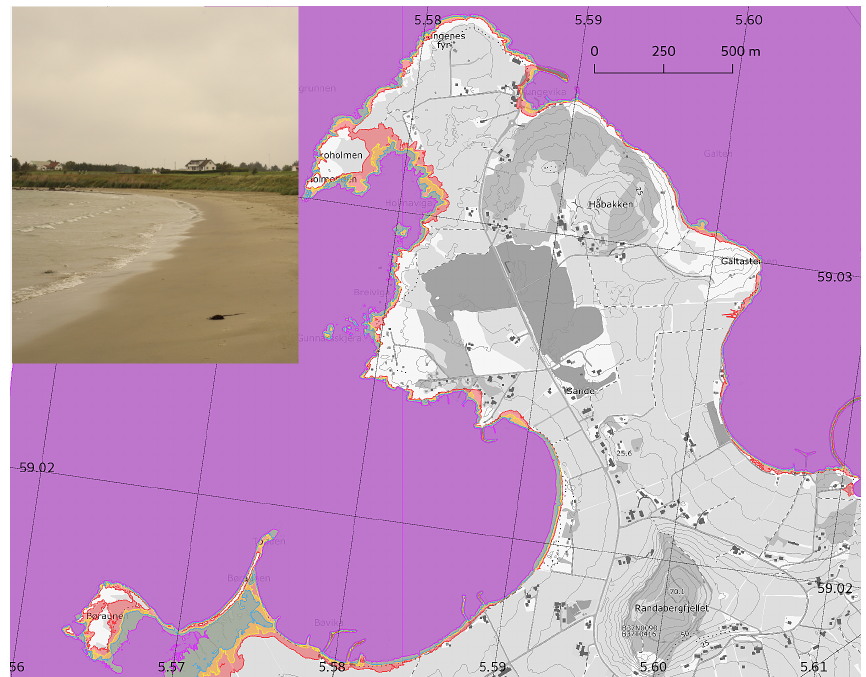
Figure 6. Stack of inundation maps covering Randaberg, located on soft moraine in the southwest of Norway. Violet: present MHW. Green: MHW for 2090 (0.79m above present MHW). Orange: present 200-year storm surge (0.99m above present MHW). Red: 200- year storm surge for 2090 (1.78m above present MHW). Inset: soft sand dunes at Sandestranda close to Randaberg. Photo: Oda R. Ravndal. Map data shown are provided by Geonorge and Norway Digital consortium and subject to the Norwegian License for Open Government Data (NLOD) 2.0 and Creative Commons BY 4.0 (CC BY